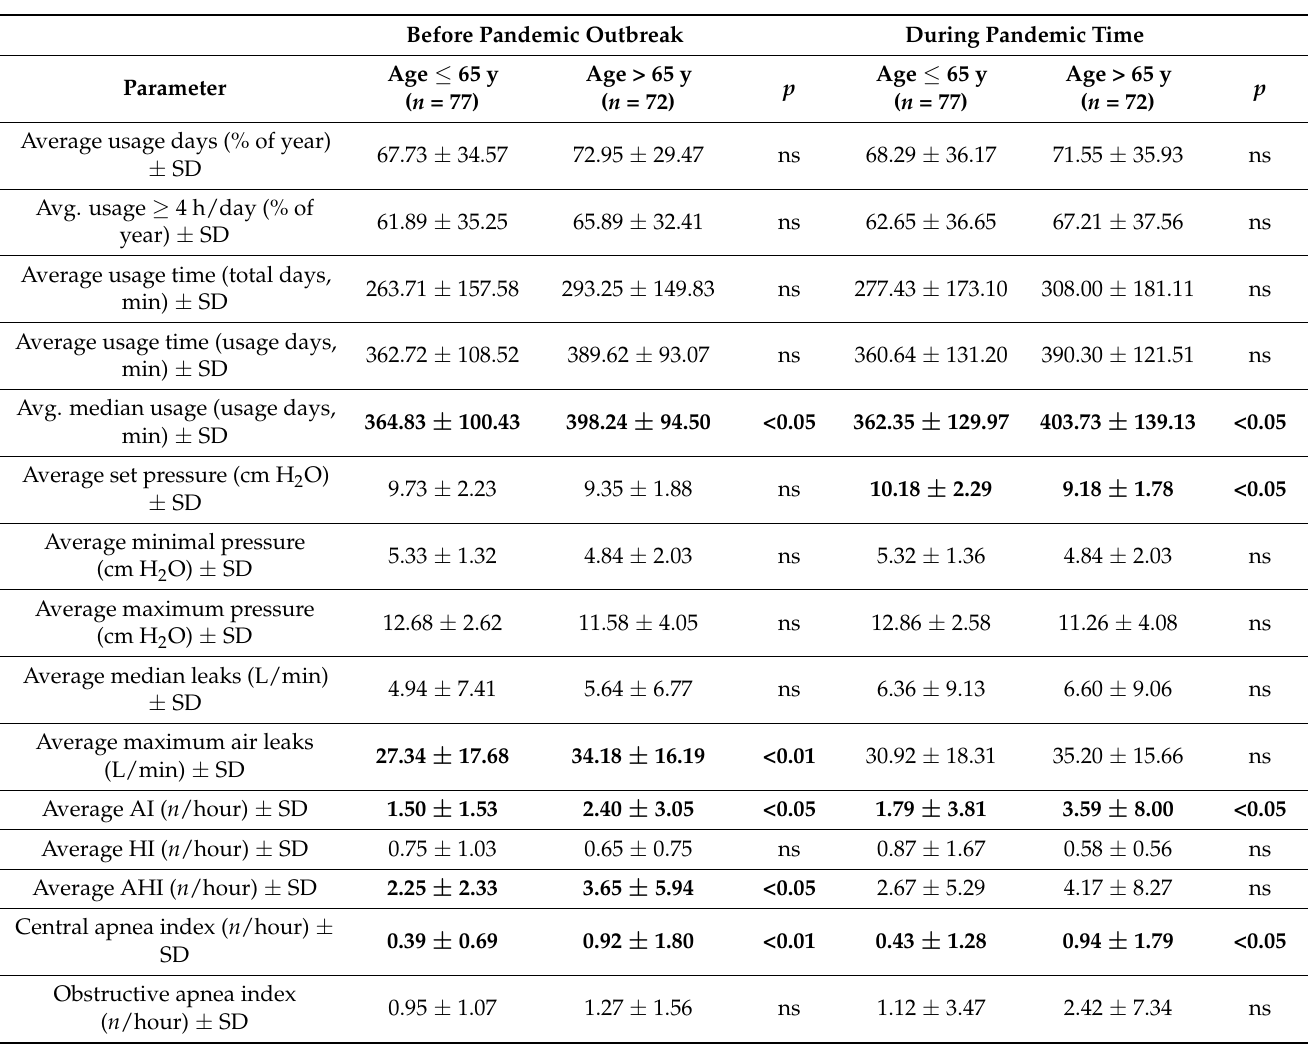
Table 3. CPAP therapy parameters and therapy adherence of study participants before pandemic outbreak and during first year of pandemic time differentiated on the basis of age. Before Pandemic